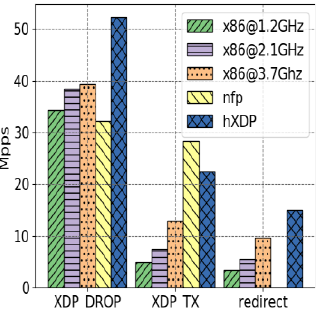
Figure 8. Baseline output measurements for basic X-data path.